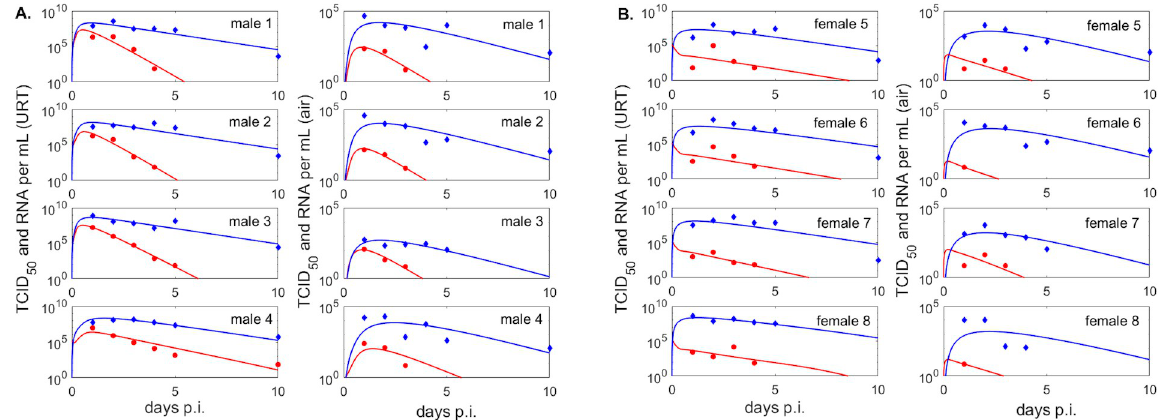
Fig 3. Infectious virus and viral RNA dynamics in upper respiratory tract and exhaled breath of male and female groups. (Left panels) Dynamics of infectious virus V (red lines) and viral RNA R (blue lines) as given by model Eq 3 versus infectious viral titers (red circles) and u u RNA (blue diamonds) in the upper respiratory tract of the (A.) males and (B.) females; (Right panels) Dynamics of infectious virus V a (red lines) and RNA molecules R (blue lines) as given by model Eq 4 versus infectious viral titers (red circles) and RNA (blue diamonds) in the exhaled a breath of (A.) males and (B.) females. Model parameters are given in Table 1.